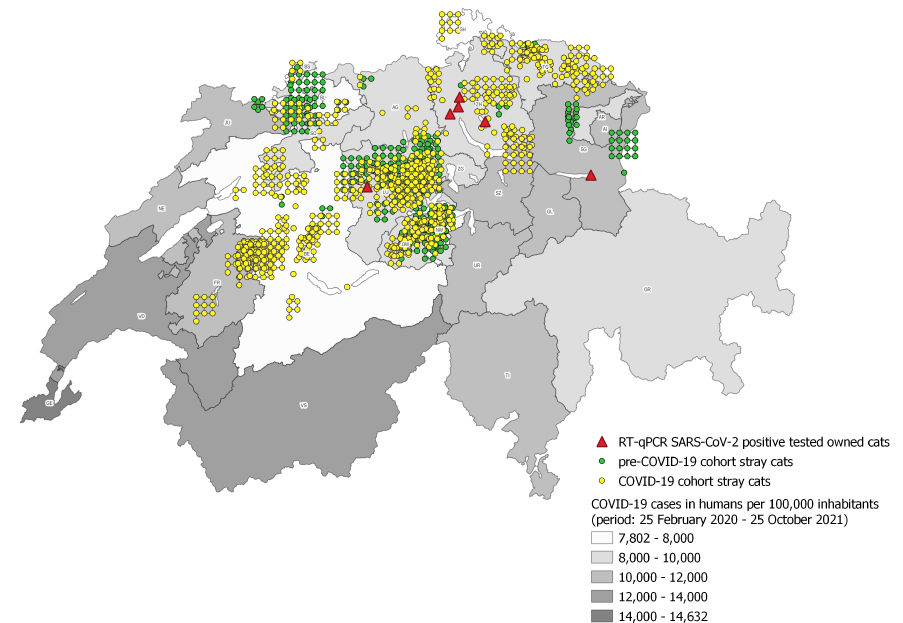
Figure 1. Geographic distribution of sampled stray cats of the COVID-19 cohort (yellow dots) and Figure 1. This is a figure. Schemes follow the same formatting. If there are multiple panels, they the pre-COVID-19 cohort (green dots). Coordinates for 39 samples are not reported (not indicated in should be listed as: ( a ) Description of what is contained in the first panel. ( b ) Description of what the Figure; this includes 16 cats with unknown canton and coordinates and 23 with known canton is contained in the second panel. Figures should be placed in the main text near to the first time but unknown coordinates). The RT-qPCR SARS-CoV-2-positive owned Swiss cats reported to the they are cited. A caption on a single line should be centered. OIE-WAHIS are marked as red triangles [26]. The background colors (grey scale) reflect the infection rates of humans per 100,000 inhabitants (period from 25 February 2020 to 25 October 2021) in the individual